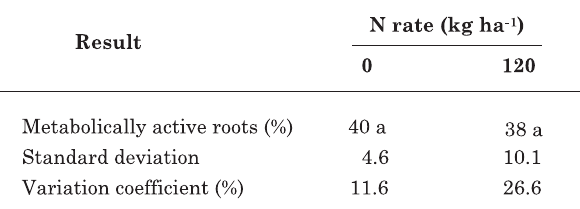
Table 6. Soil density in the trenches at sugar cane harvest, at different locations and depths. Results correspond to the mean of 16